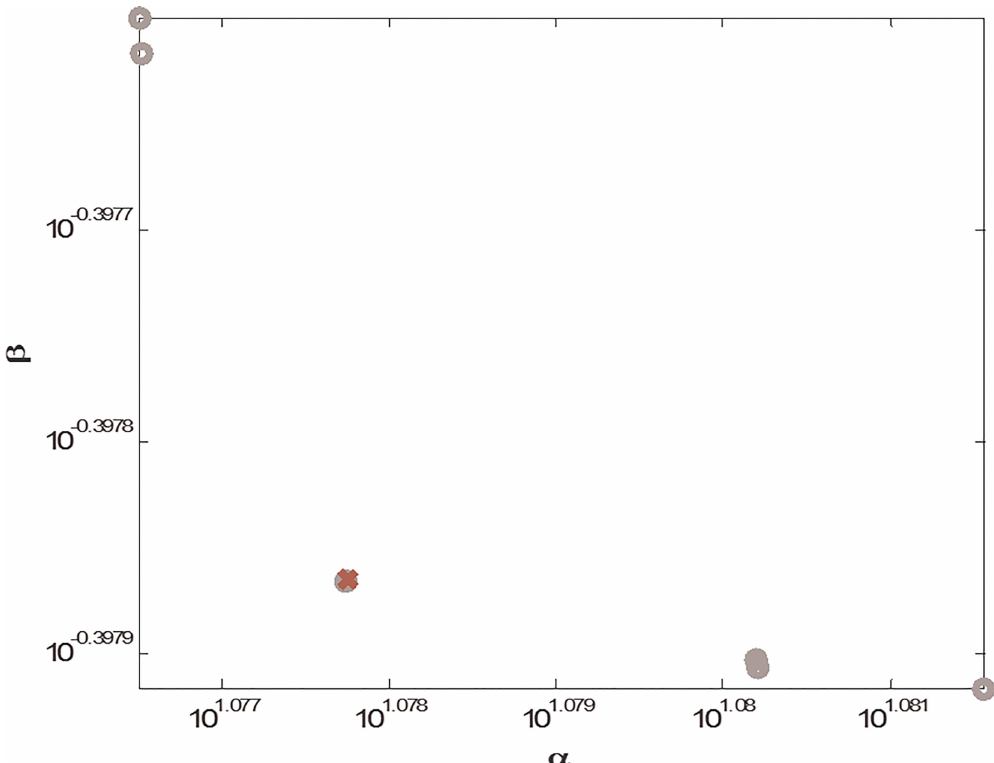
Fig 2. Pareto front obtained by solving the multi-objective problem in (21) through the proposed MOEA- based library search method from Tables